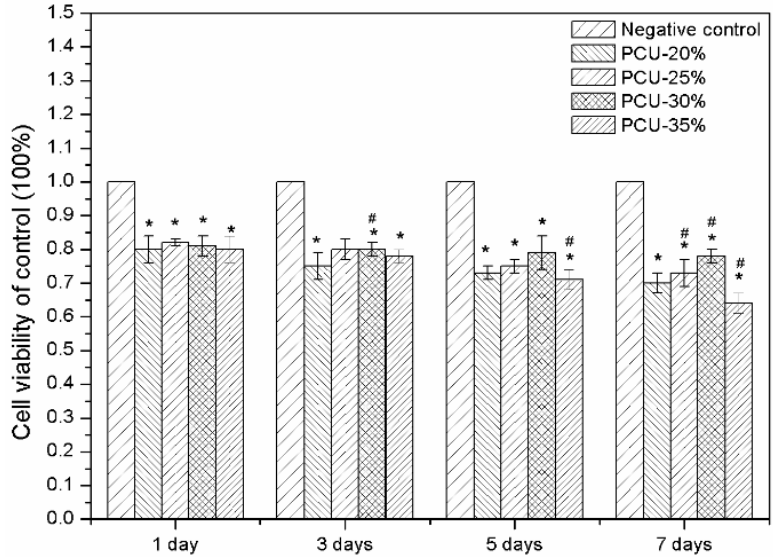
Figure 7. Micrographs of L929 cells with the materials and the toxicity of the membranes obtained by submersing the samples in media for 3 days. The scan bar on the images is 200 µm. A concentration series of high-density polyethylene liners served as the negative control ( n = 6, p < 0.05, mean ± SD; *: represents a significant difference compared to the control. #: p < 0.05 significant below 70% value).